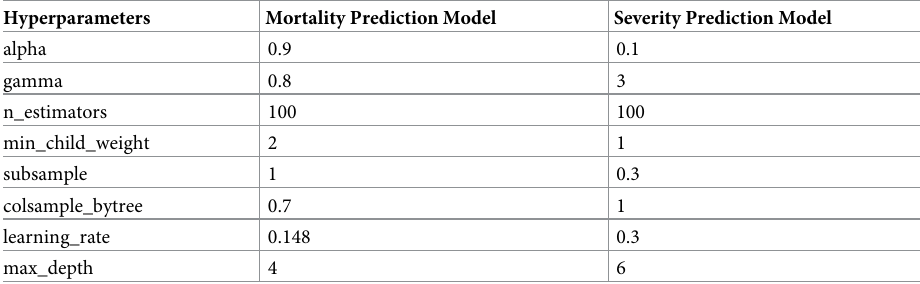
Table 3. List of Hyperparameters used in the